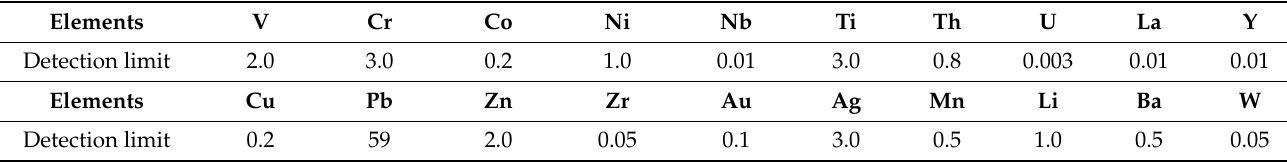
Table 1. Analytical detection limits of